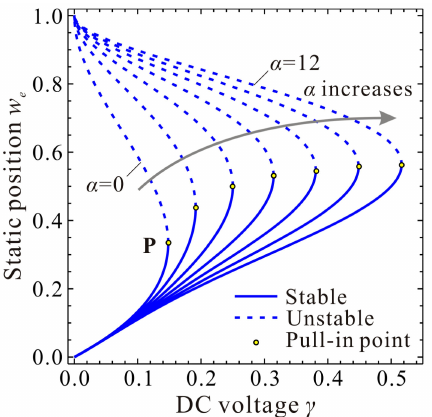
Figure 2. Evolution of the static position w e versus direct current (DC) voltage γ for different cubic stiffness α .